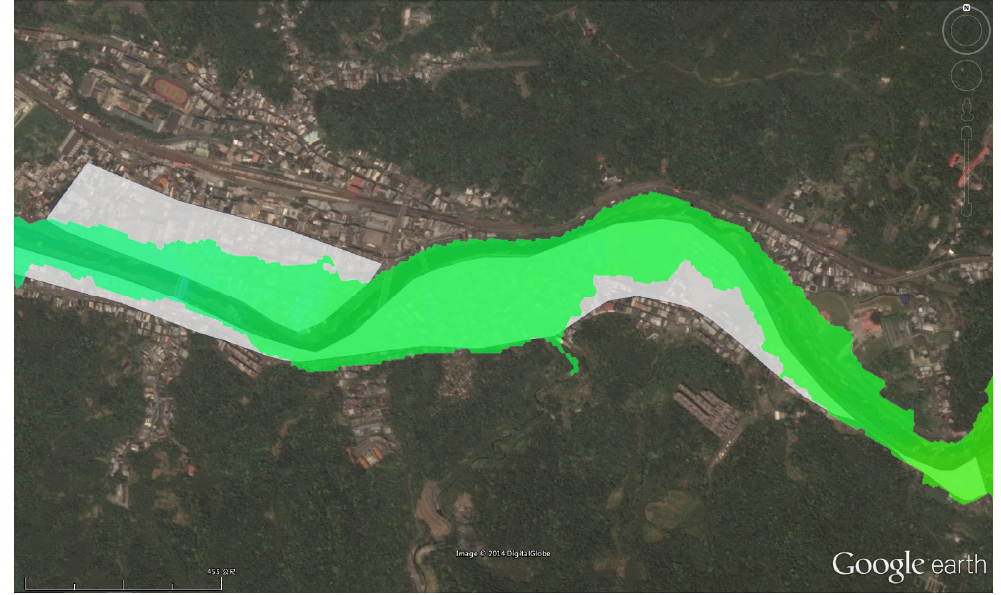
Figure 5. Model (green color)-data (white color) comparison of the inundation extent during Typhoon Nari